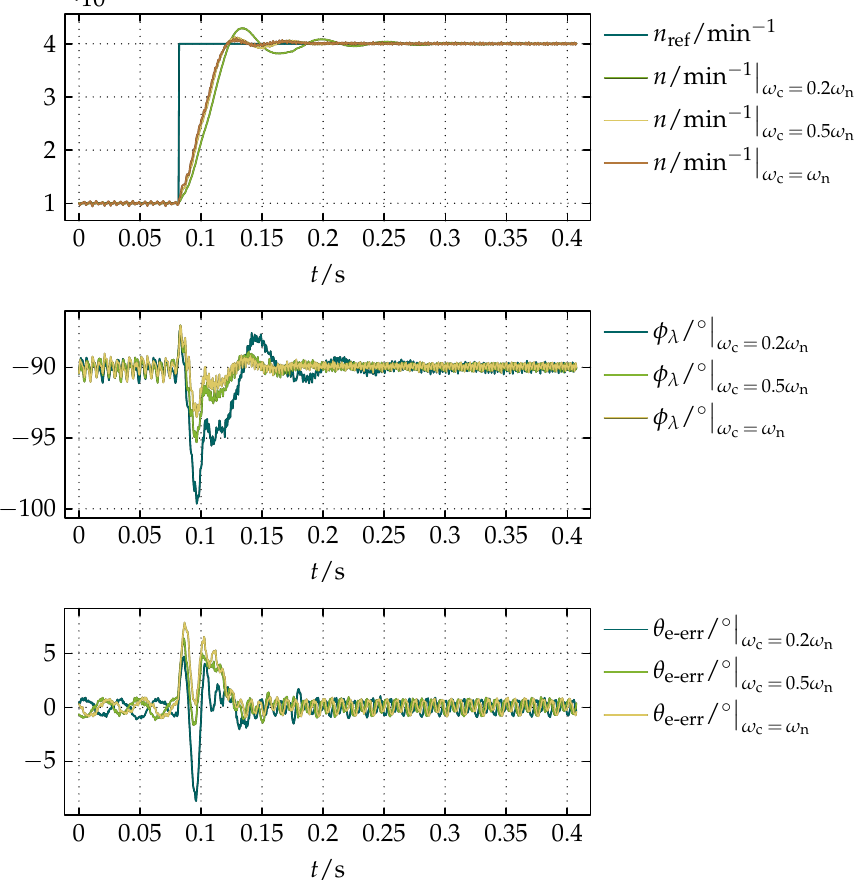
Figure 16. Results of comparative experiments of a step in n from 1000 to 4000 min − 1 for k = 0.5 and variations in ω c